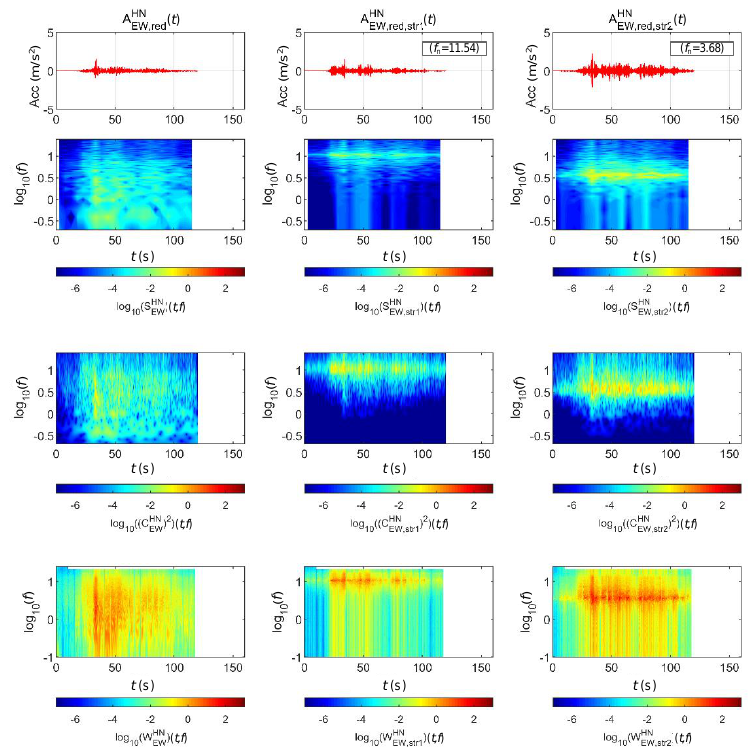
Figure 17. Analysis results of the Hachinohe earthquake data (scaled for 1000-year return period) and associated bridge response.